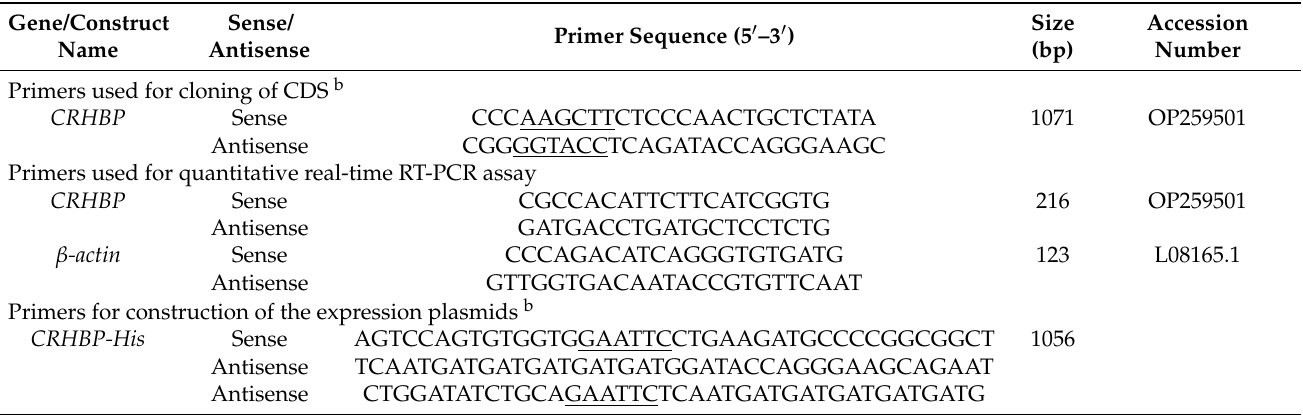
Table 1. Primers used in this study a